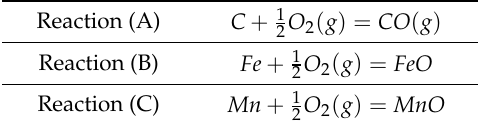
Table 1. Oxidation reactions (A) to (C) considered in present